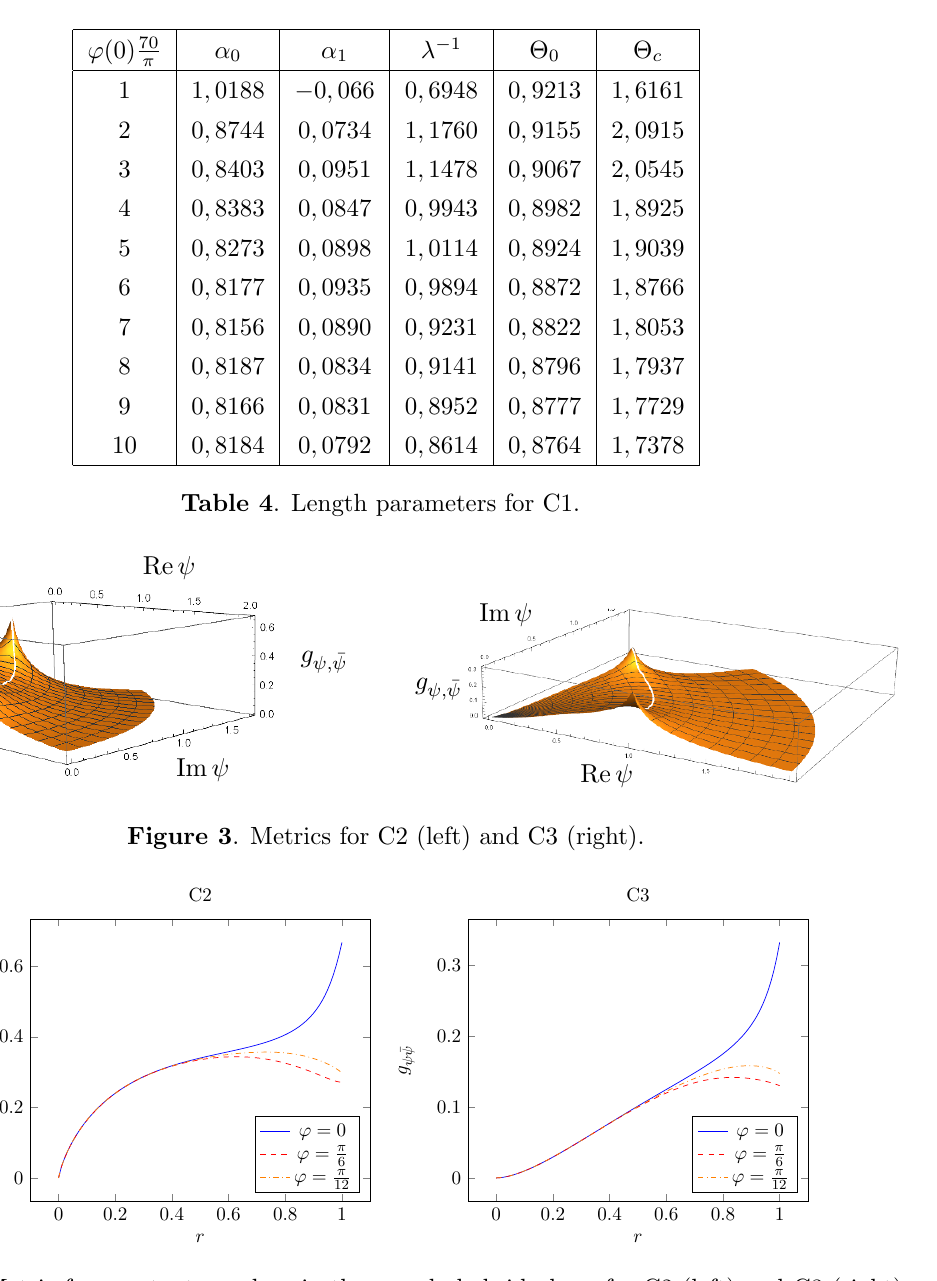
Figure 4 . Metric for constant ’ values in the pseudo-hybrid phase for C2 (left) and C3